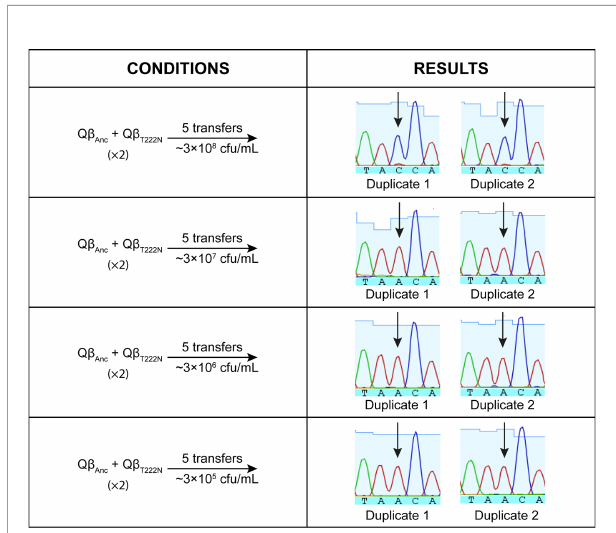
FIGURE 5 | Competition experiment between the viruses Q b Anc and Q b T222N. The left part of the fi gure shows the conditions for the competition (described also in Materials and Methods). The right part shows the chromatograms of the populations obtained after the competition around nucleotide position 2011 (marked with an arrow). The presence of a C at this position indicates that the mutant has not an advantage over the wild-type virus, whereas the presence of an A indicates the opposite.